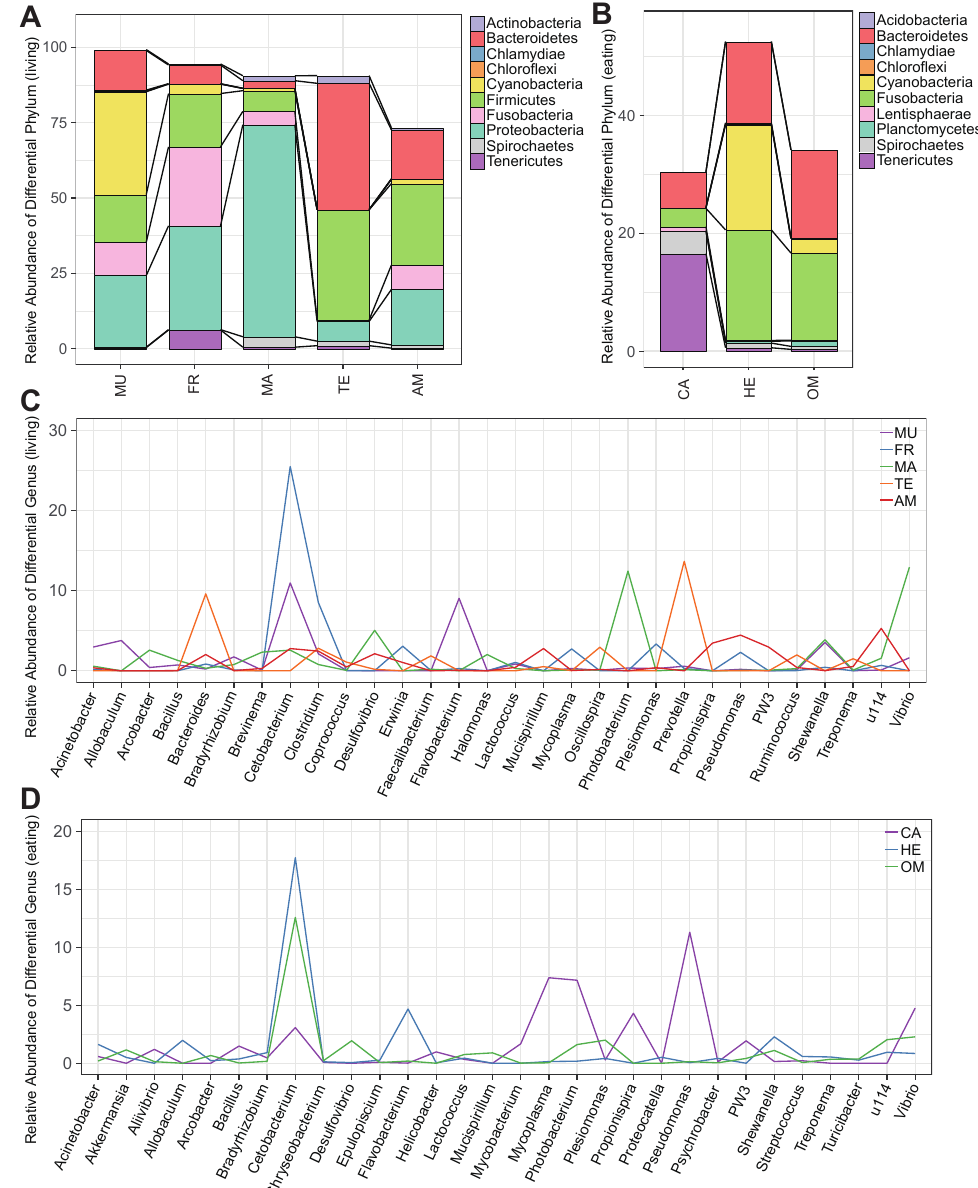
Figure 3. Relative abundance of taxonomic compositions among the examined groups. ( A ) The top 10 abundant phyla in mudskippers (MU) in comparison with other four groups with di ff erent living habitats (AM: amphibians, FR: freshwater fishes, MA: marine fishes, TE: terrestrial animals); ( B ) the top 10 abundant phyla in carnivorous (CA) species in comparison with herbivorous (HE) and omnivorous (OM) groups; ( C ) the top 30 abundant genera in mudskippers and ( D ) in herbivorous species in comparison with other